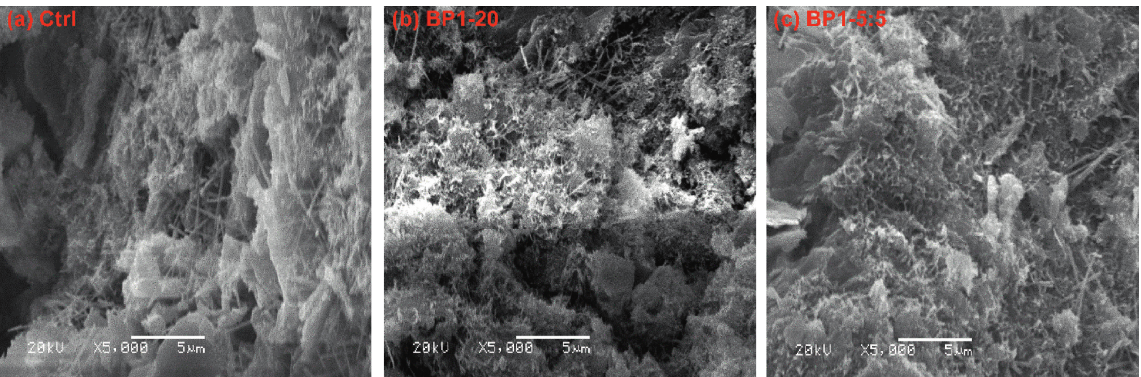
Figure 6: The SEM images of (a) control specimen, (b) BP1 20, and (c) BP1 5: